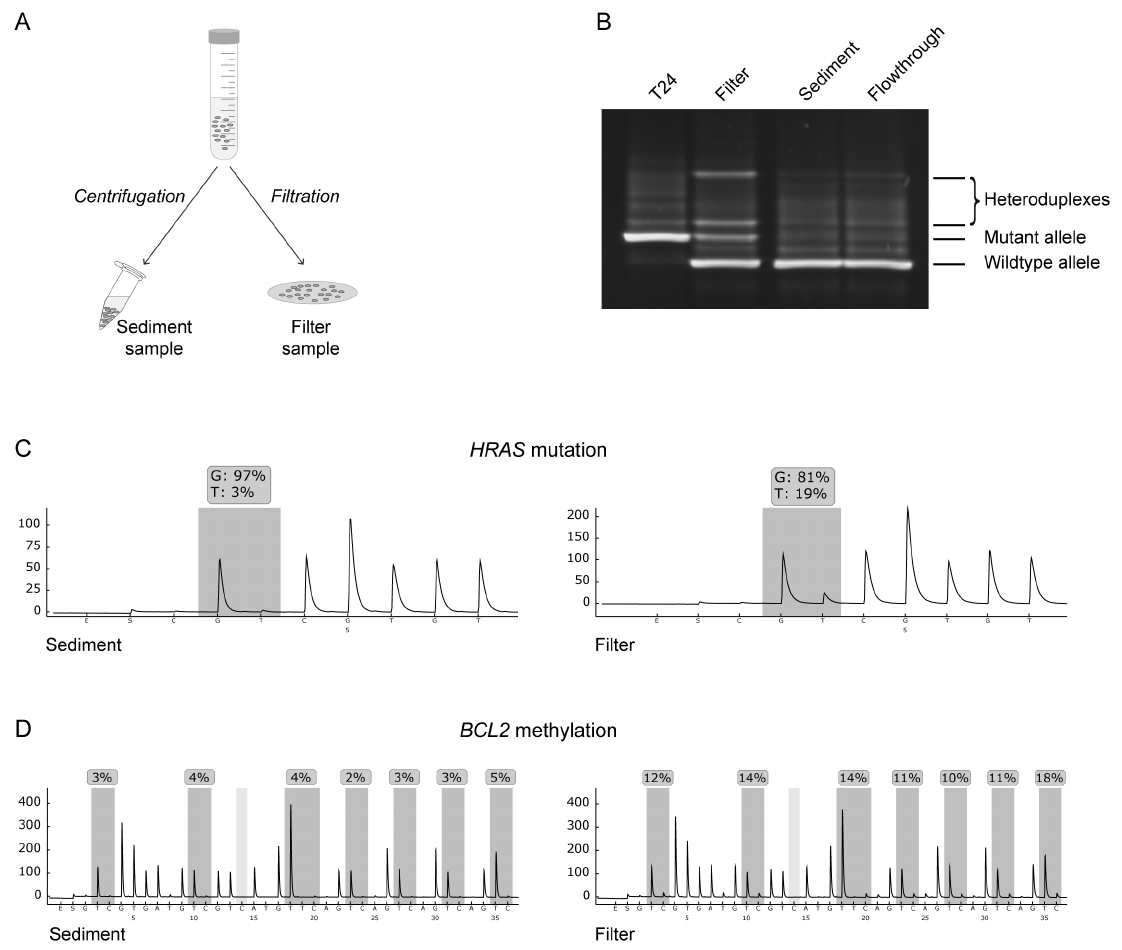
Figure 1. Filter-based capture and enrichment of bladder cancer cells. ( A ) Schematic drawing of the split-sample experimental set-up. Urine sample or cell suspension is divided in two and subjected to centrifugation and filtration, respectively. DNA from cells in sediment or captured on filter is then isolated and analyzed for tumor-specific markers. ( B ) Detection of the HRAS p.G12V mutation by DGGE. The cell line T24 is homozygous for the mutant allele. Sediment and flowthrough samples display only the wildtype allele, while the filter sample shows both mutant and wildtype alleles. Heteroduplexes are hybrid molecules made up of one mutant strand and one wildtype strand. ( C ) Pyrographs showing the distribution between wildtype (G) and mutant (T) HRAS alleles in the sediment and filter samples. ( D ) Pyrographs of BCL2 promoter CpG island methylation analysis in the sediment and filter samples. The individual CpG sites in the target region are indicated by dark grey shading, and the percentage of methylated alleles (C) is indicated at each